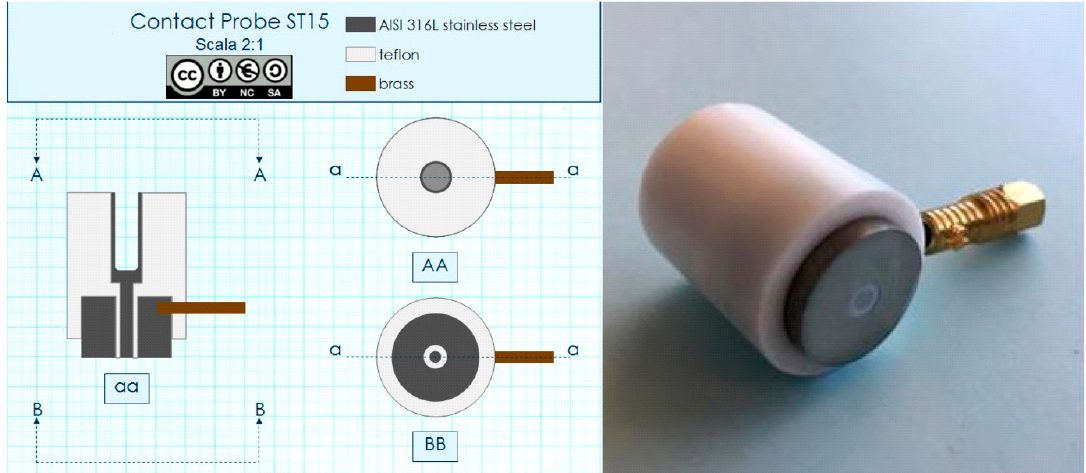
Figure 2. A Contact Probe (CP), reproduced and reprinted with permission from [30].